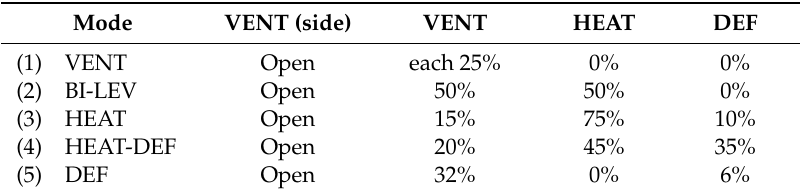
Table 2. Air flow distribution ratios.